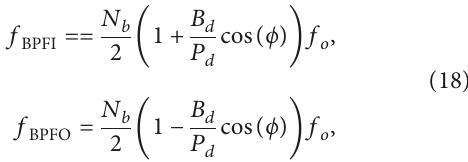
Figure 23: Photos of (a) test bench and (b) measurement